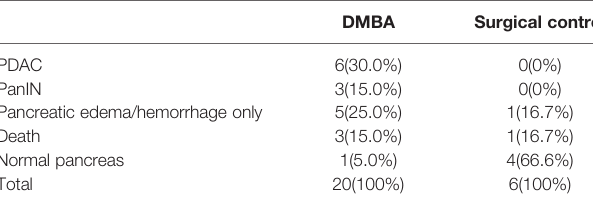
TABLE 3 | Statistical results of PDAC animal